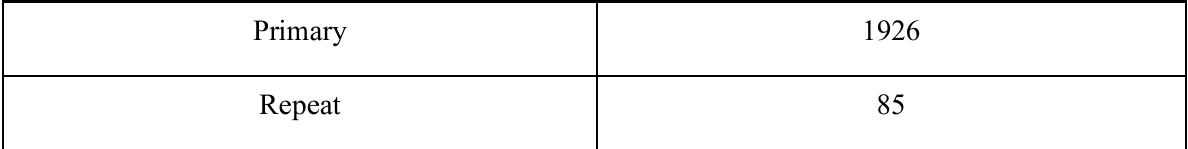
Table 4: Types of Cesarean Section